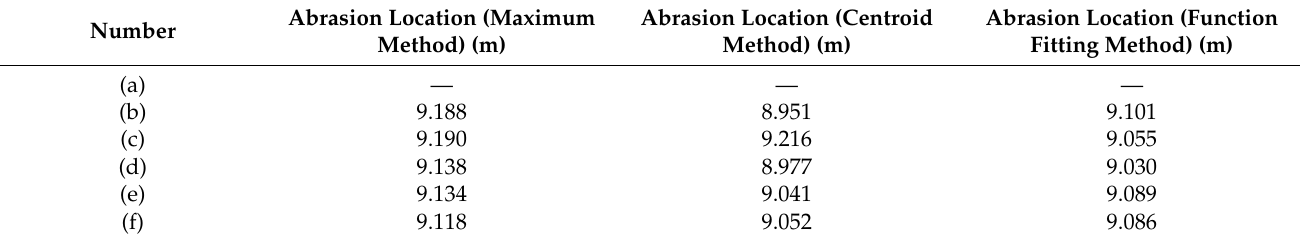
Table 1. The abrasion locating results of (a)–(f) samples.